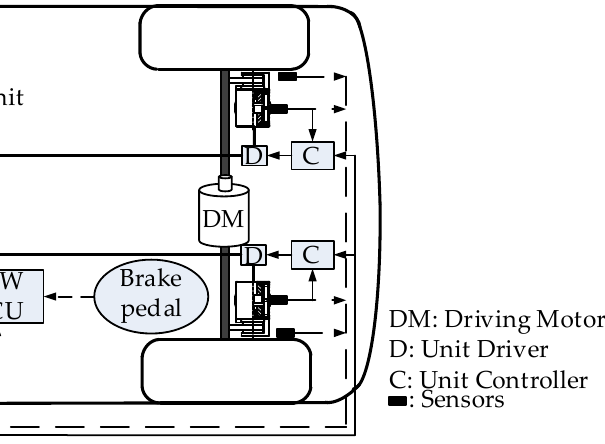
Figure 9. The structure of BBW in electric vehicle.